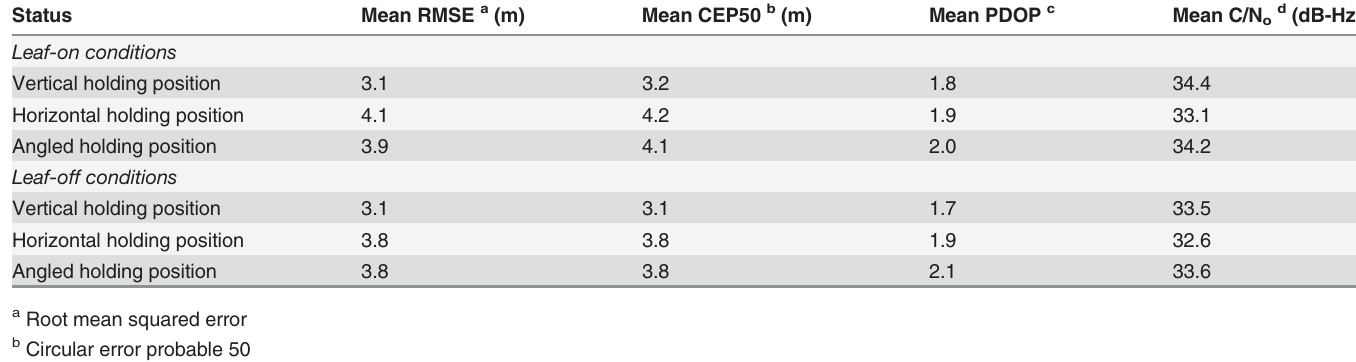
Table 3. Mean static horizontal position accuracy, PDOP, and signal-to-noise values for the Flint GNSS receiver in the coniferous stand ( n =